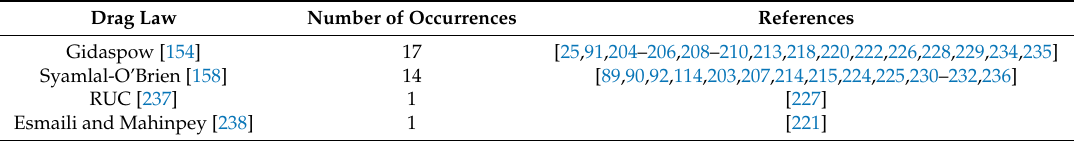
Table 8. Drag laws used in TFM